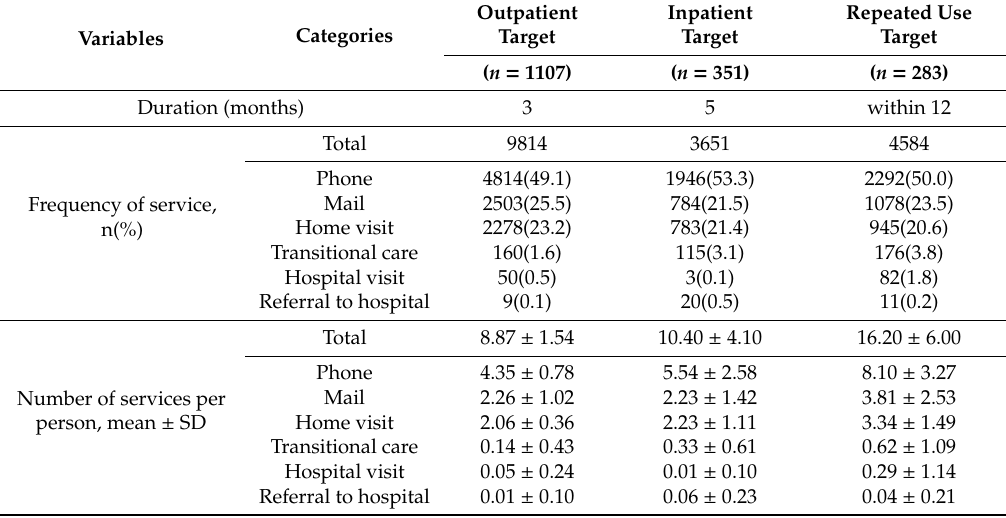
Table 2. Service duration and performance of community-based case management by target groups.